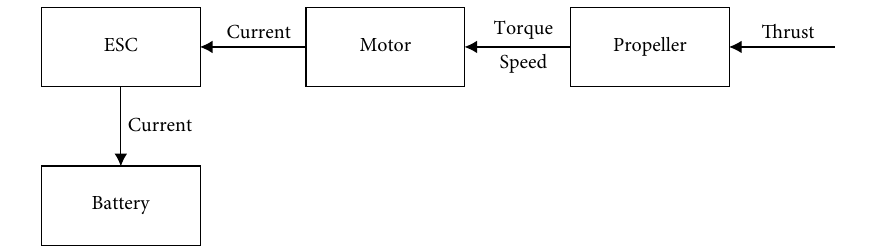
Figure 3: Inverted multirotor propulsion chain diagram.